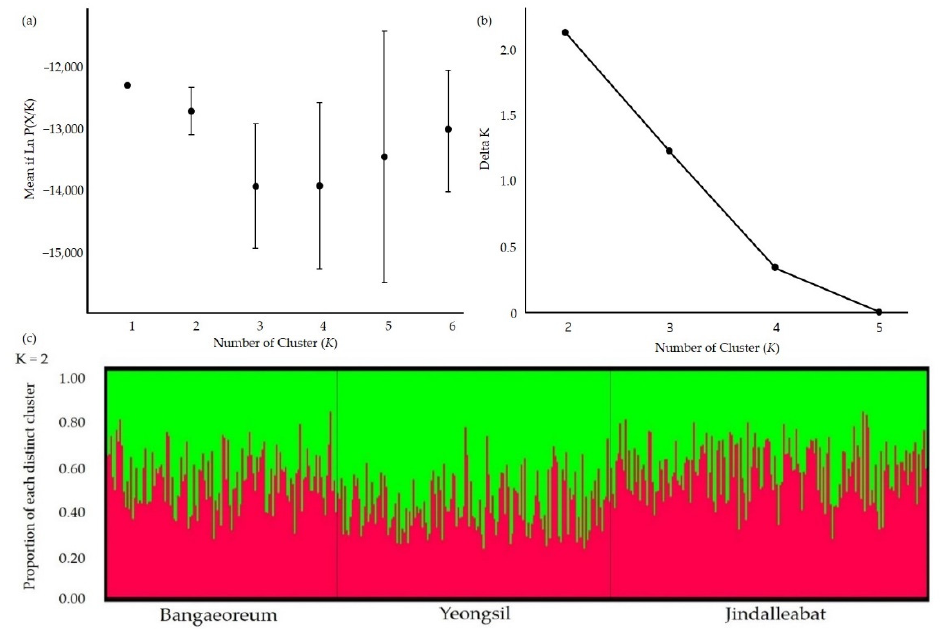
Figure 3. Results of Bayesian clustering analysis using STRUCTURE. ( a ) The mean log-likelihood value (± standard deviation) of the data was based on 40 repetitions for each K value. ( b ) The delta K value was changed with each K value. ( c ) The proportion of cluster membership at the population level in the three subpopulations of Abies koreana, assuming K = 2. The horizontal bars denote the samples; the green and red shades represent the genetic clusters.